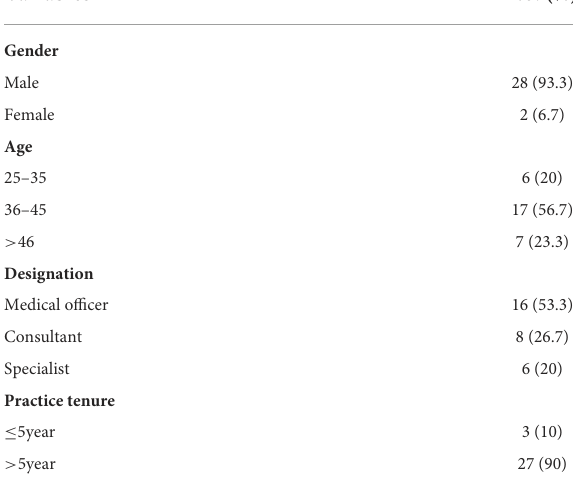
TABLE 1 Sociodemographic characteristics of